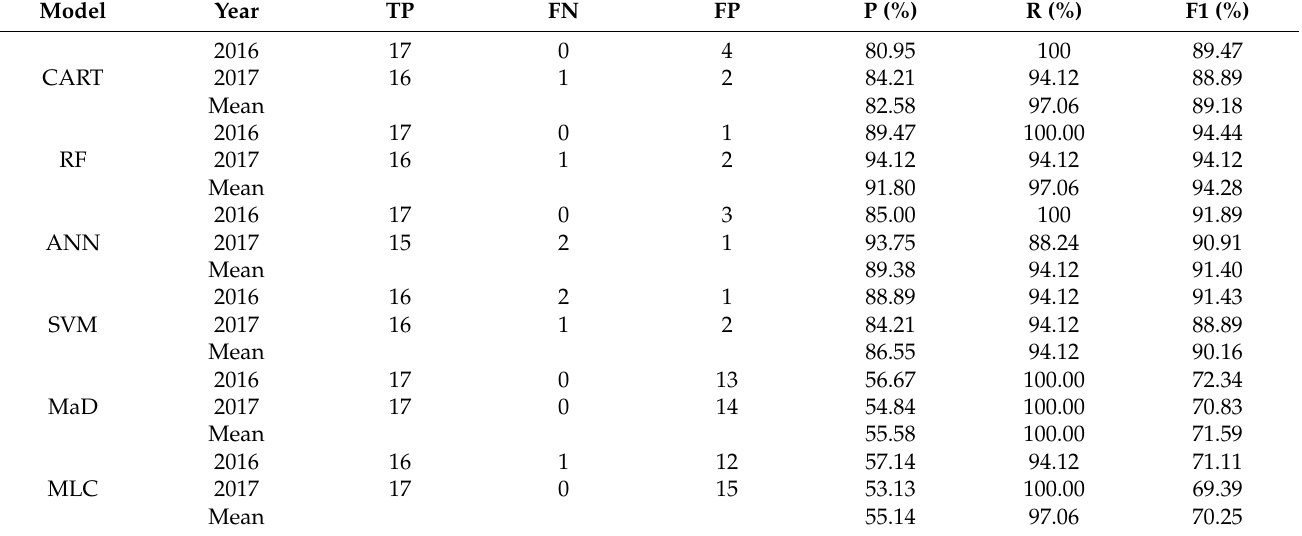
Table 1. Accuracy evaluation in region 1.